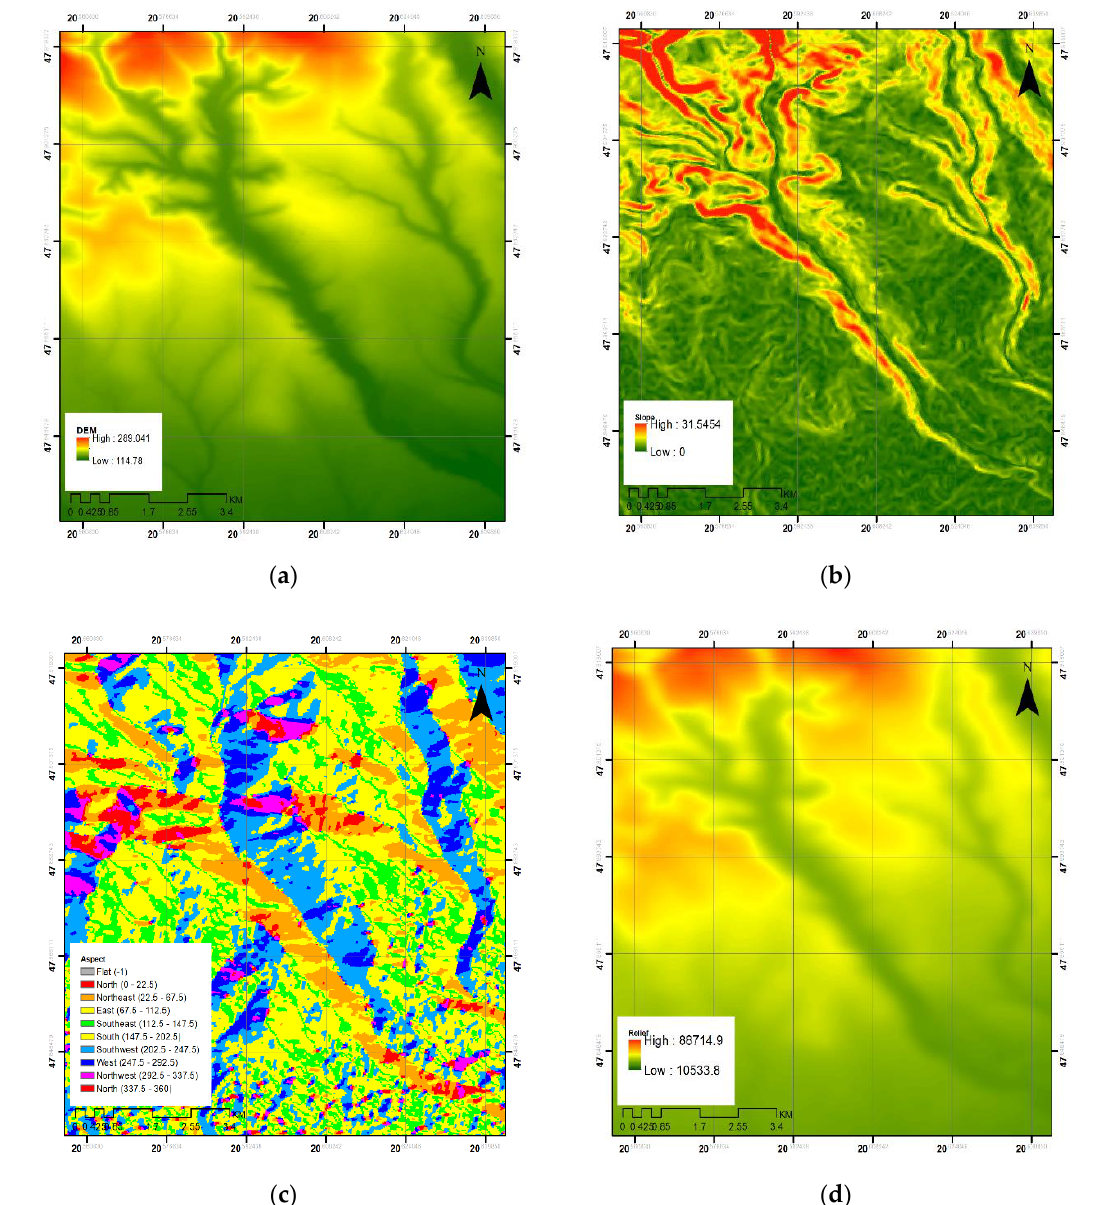
Figure 4. ( a ) Digital Elevation Model (Metres Above Sea Level) and environmental covariates; ( b ) slope (degrees°); ( c ) aspect and ( d ) relief.